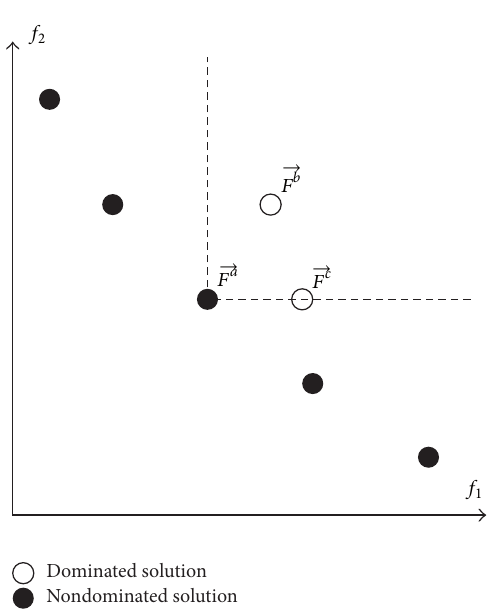
Figure 1: Dominance relation for two objectives